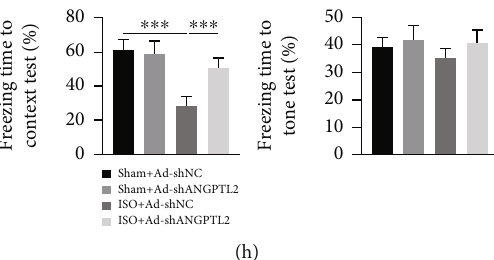
Figure 1: Downregulation of ANGPTL2 improved iso fl urane-induced cognitive dysfunction in mice. (a) Pathological change was detected using HE staining. (b) ANGPTL2 mRNA level was measured using qRT-PCR. (c, d) Western blotting was used to examine expression of ANGPTL2 and β -actin protein level. (e) HE staining was performed to observe pathological change. (f, g) Morris water maze task was used to detect escape latency time, target quadrant time, and platform crossing time. (h) FCT was carried out to measure freezing time to context test and freezing time to tone test. n = 6 . ∗∗ p < 0 : 01 ; ∗∗∗ p < 0 : 001 .